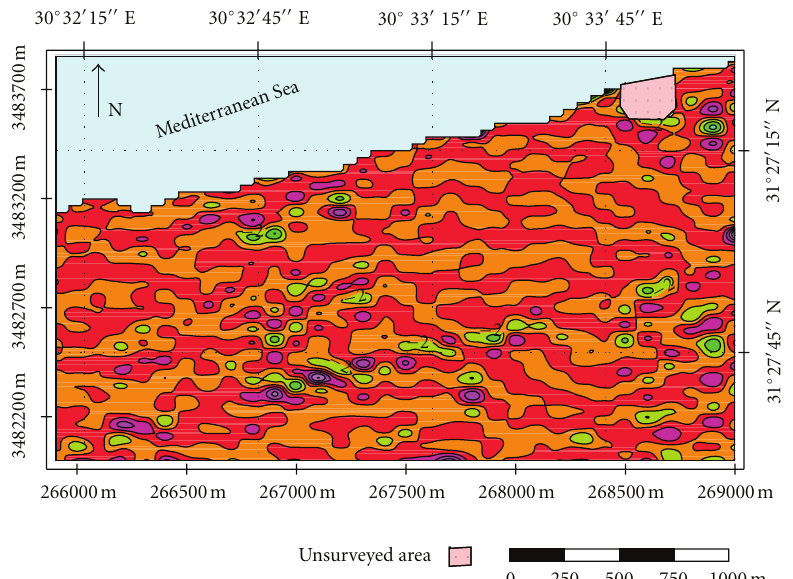
Figure 6: Filled colour contour map of the residual component of magnetic-field intensity of Koam Mashaal area, East Rosetta, Mediterranean Sea Coast, Northern Egypt at an average depth ( h ) of 9.1m, contour interval =